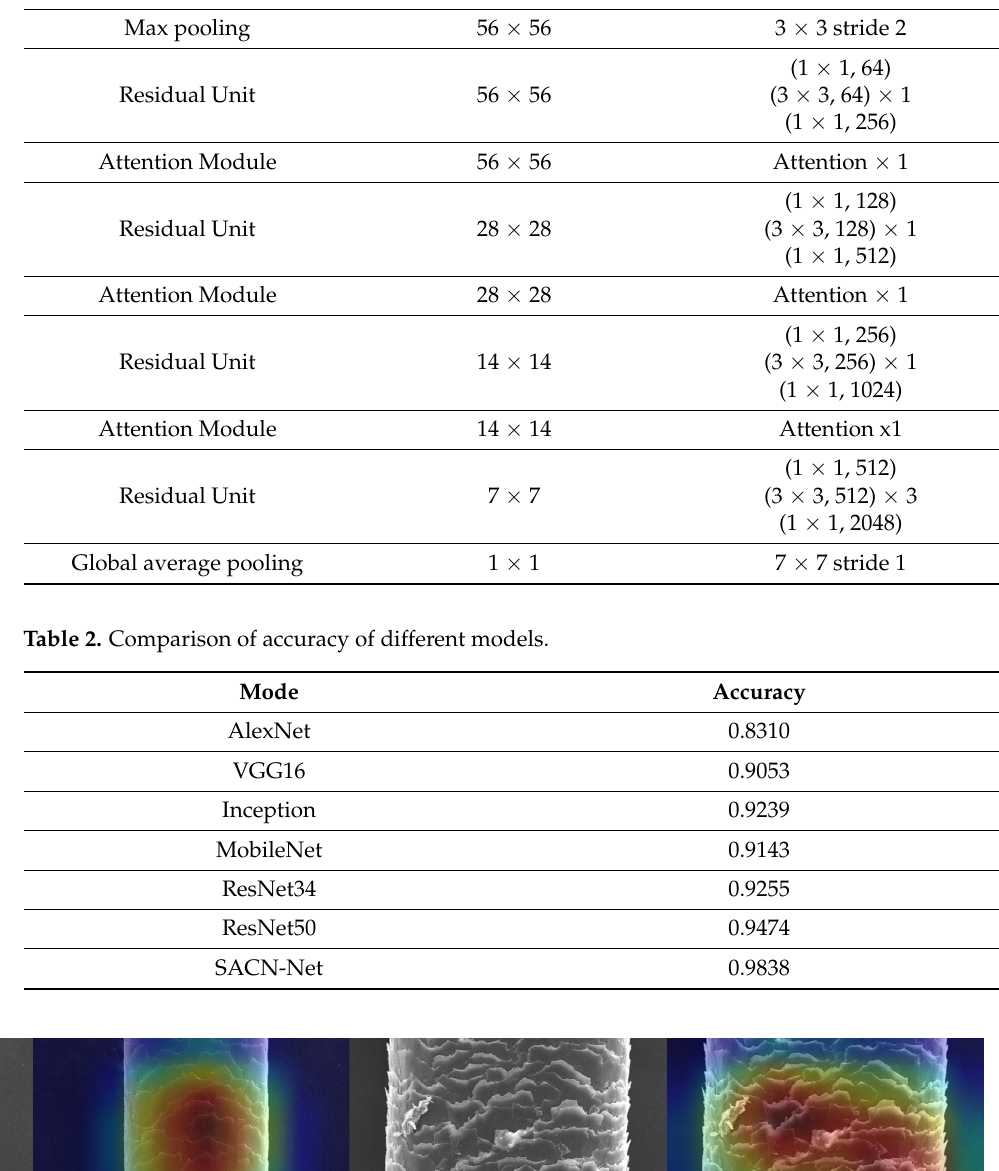
Table 1. The Configuration parameters of SACN-Net.